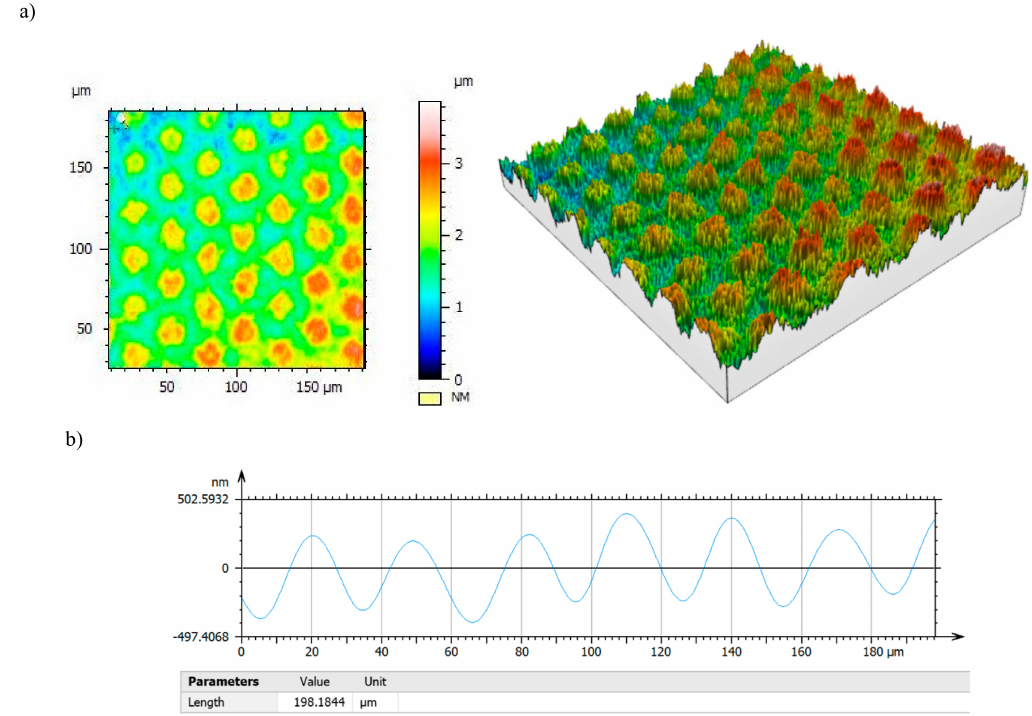
Figure 6. ( a ) Surface topography after laser texturized cemented carbides, ( b ) profile of obtained surface.